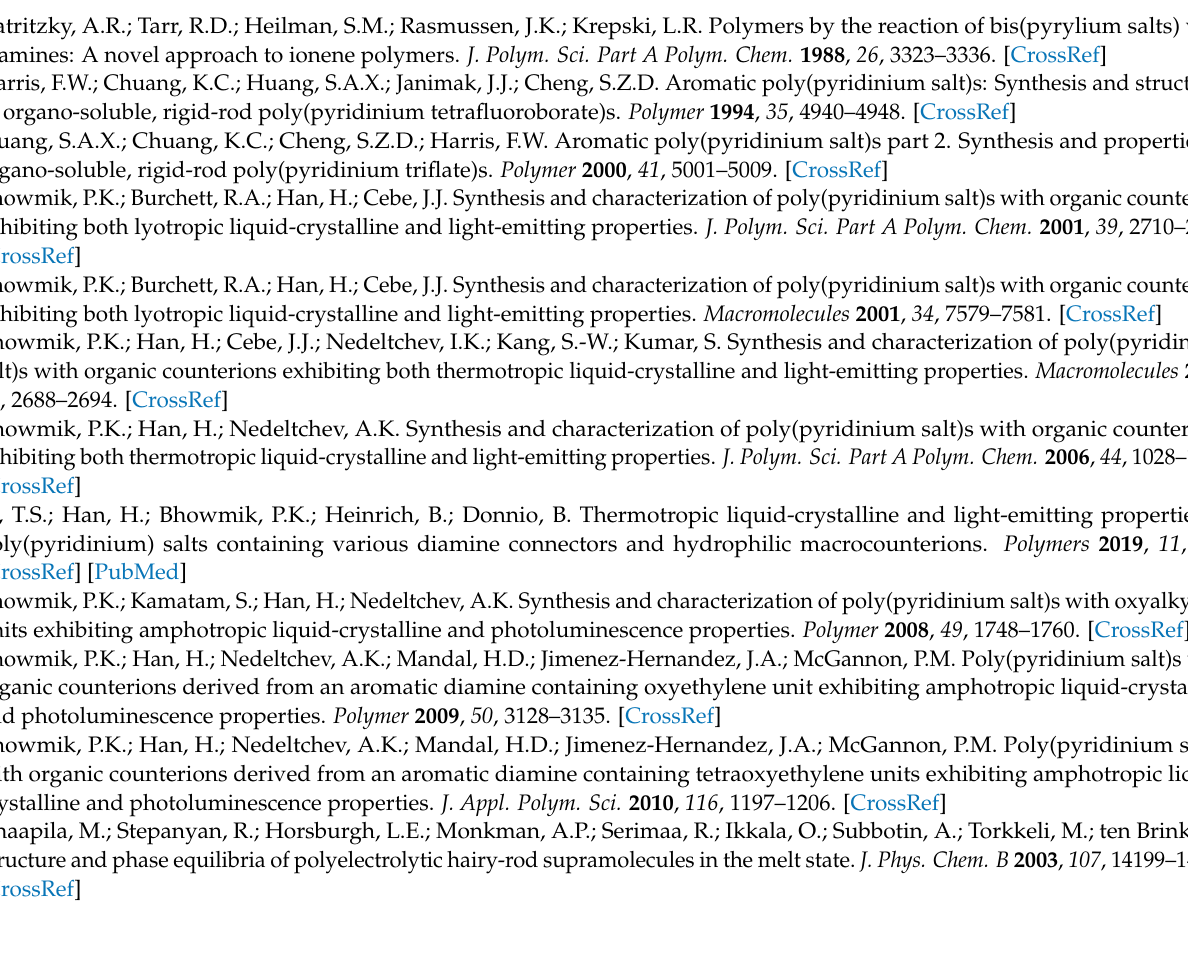
Figure S13: Emission spectra of polymer 5 in CH 3 OH/H 2 O, and Figure S14: Fluorescence intensity and emission peak of polymer 5 as a function of water content in CH 3